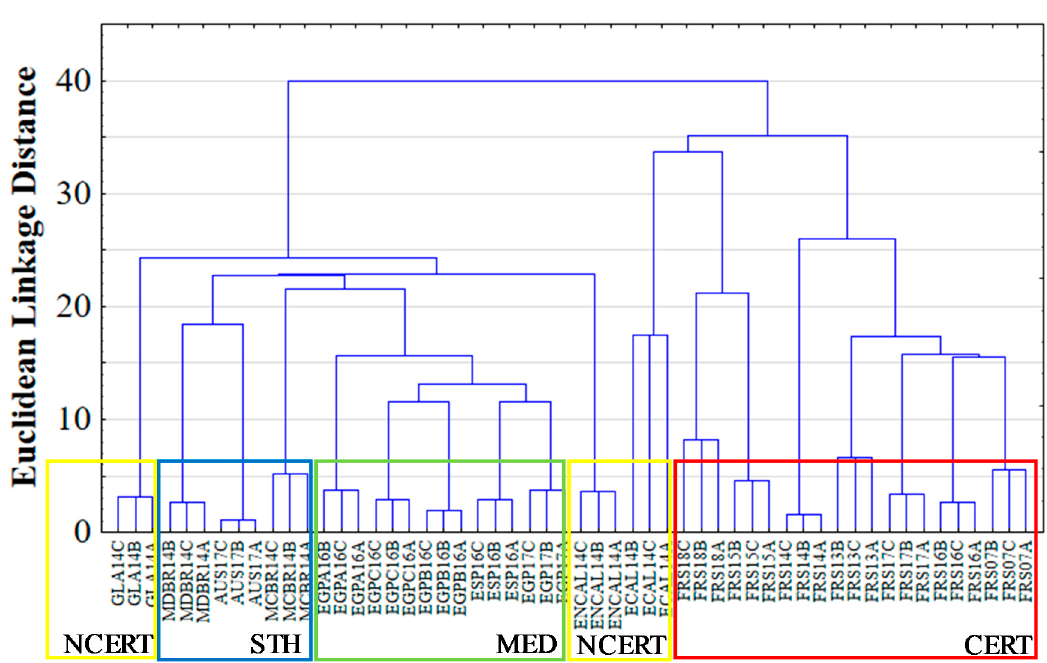
Figure 4. The HCA dendrogram for all replicates (A, B and C) from all samples (NCERT- non-certified producer; STH- Southern hemosphere region producers; MED- Mediterranean region producers; CERT- certified producer.